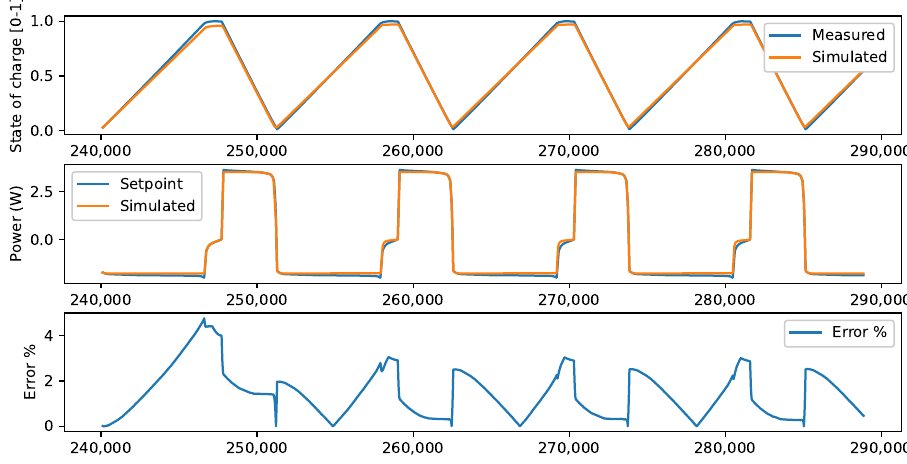
Figure 6. Battery model calibrated with sample data SNL_18650_LFP_25C_0-100_0.5-1C_d_timeseries.csv from